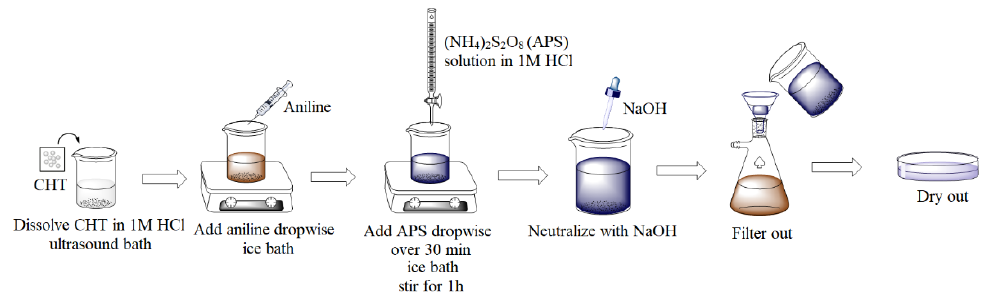
Figure 5. Generalized synthetic procedure for PANI/CHT binary composites.